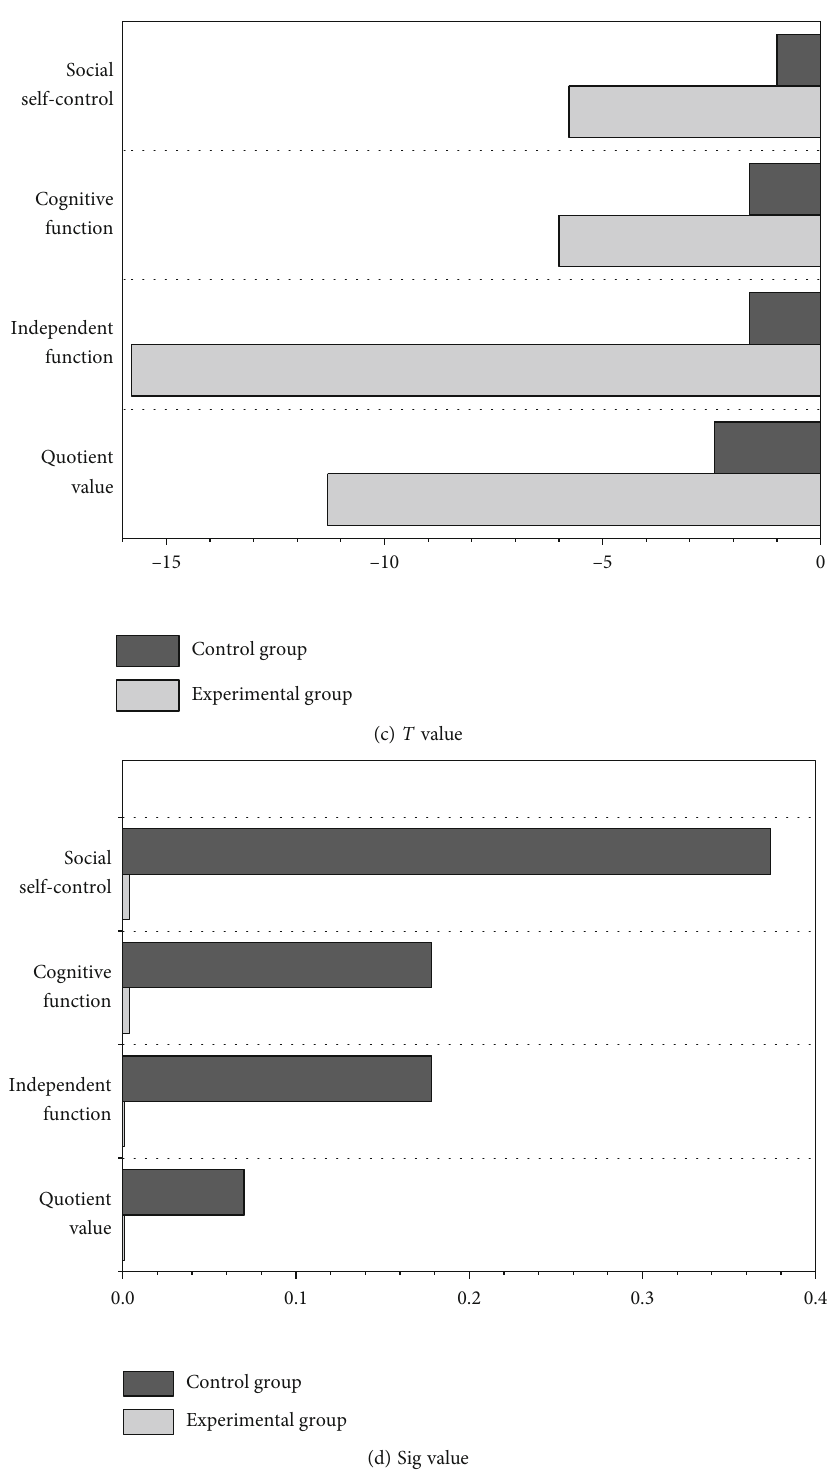
Figure 8: Comparison of pretest and posttest di ff erences of social adaptability between the experimental group and control